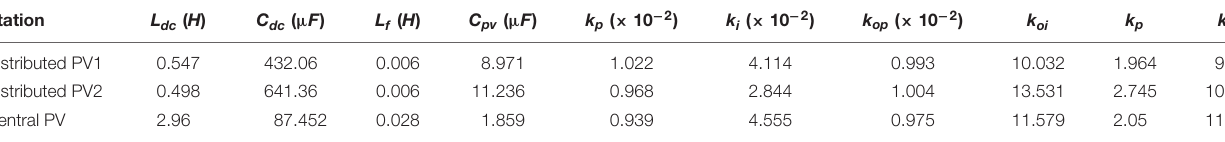
TABLE 3 | Physical and control parameters of equivalent models.